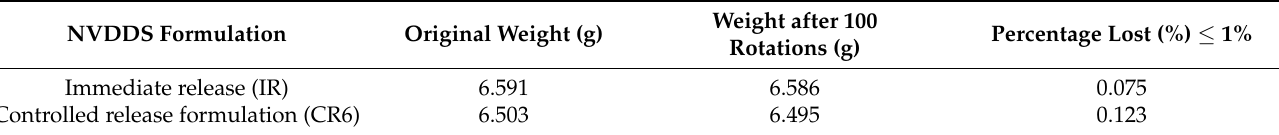
Table 4. Testing selected formulations for tablet friability ( n = 35).